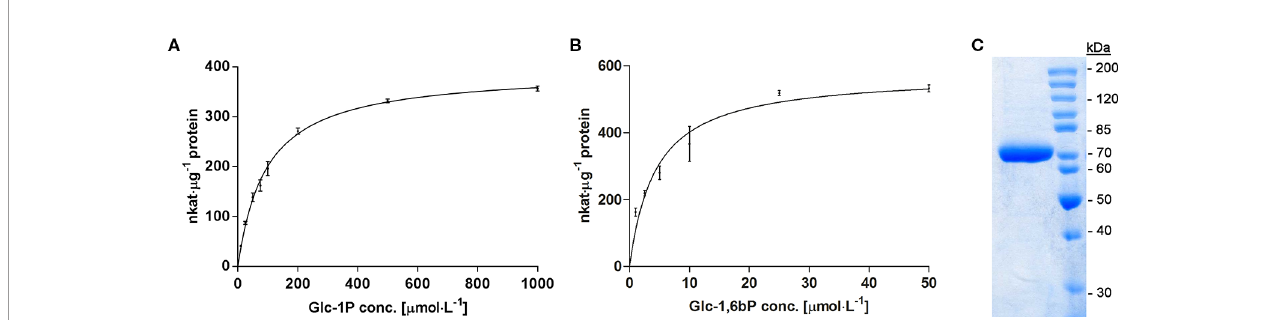
FIGURE 3 | (A) Enzyme kinetic of recombinant PGM3 with increasing concentration of the substrate Glc-1P (10 to 1,000 µmol·l − 1 ), showing a hyperbolic curve with a K m of 90 µmol·l − 1 . (B) Kinetic of PGM3 for the co-substrate Glc-1,6bP that is needed as a catalytic intermediate. The low K m of 4.3 µmol·l − 1 demonstrates the high af fi nity of PGM for this co-substrate. PGM Assays were performed at 25°C for 3 min. Values are averages of three independently performed assays (± SD).